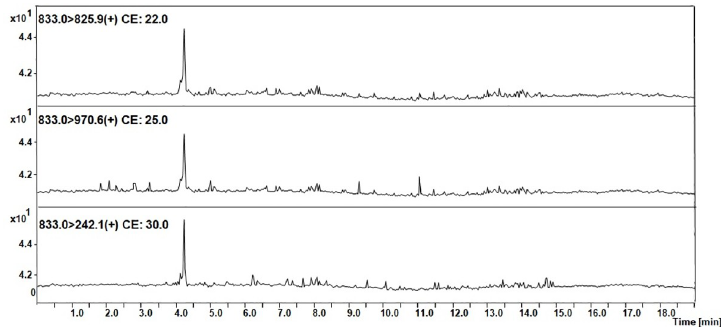
Fig 3. MRM chromatograms representing transitions corresponding to the model peptide with the 169 H-LQTLEIPFHEIVTK-OH 182 sequence identified in the tryptic digest of an equine urine sediment sample from animal with diagnosed AKI.